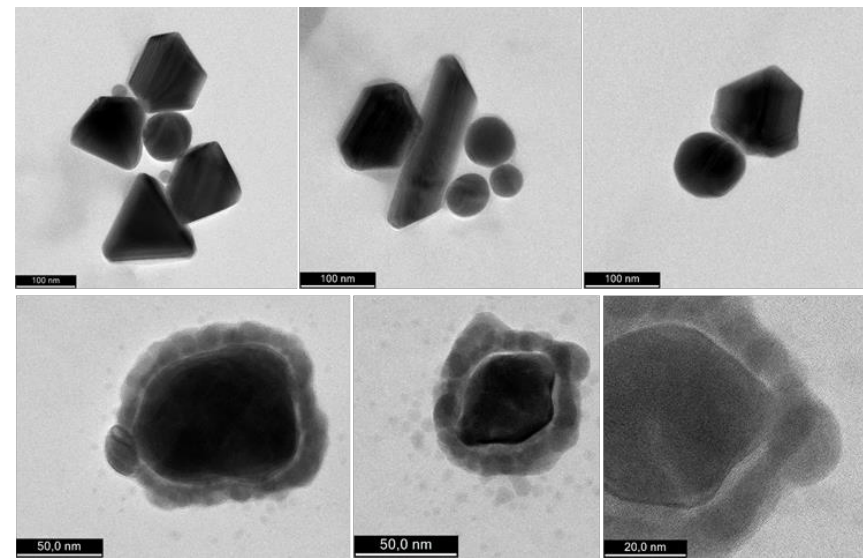
Figure 12. TEM images of AgNPs ( top row ) and the phytocarrier system ( bottom row ).